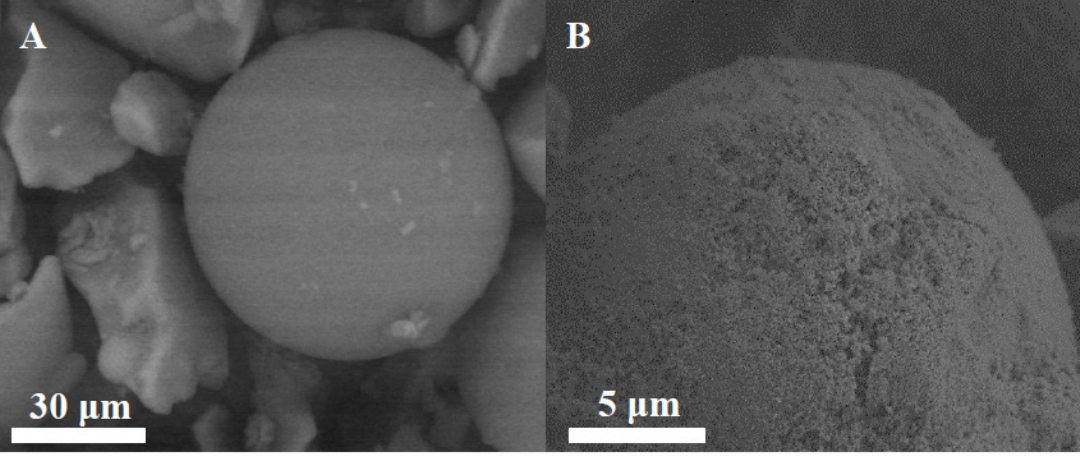
Figure 3. SEM micrographs of amorphous silicas: MS-3030 ( A ) and MS-3030-G-N ( B